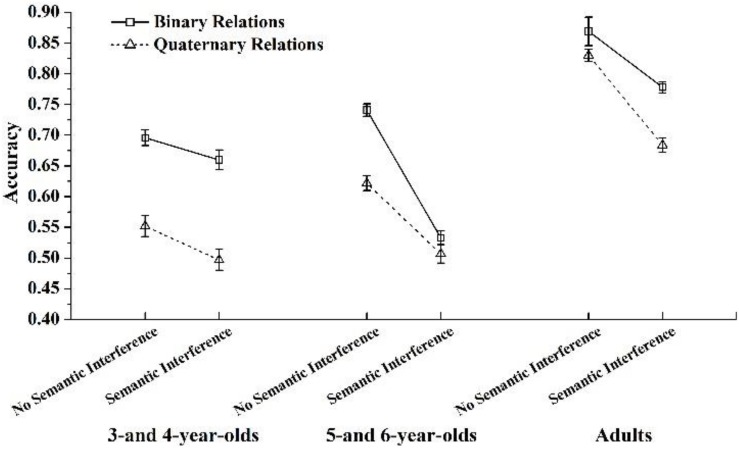
Accuracies as a function of relational integration and semantic interference across age groups.